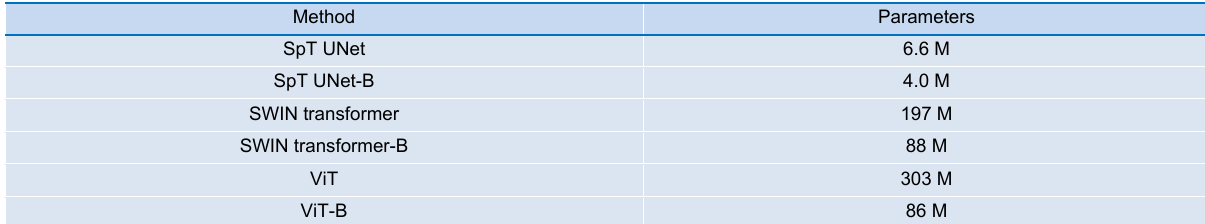
Table 3 | The comparison of the SpT UNet, ViT, and SWIN transformer on parameter numbers.